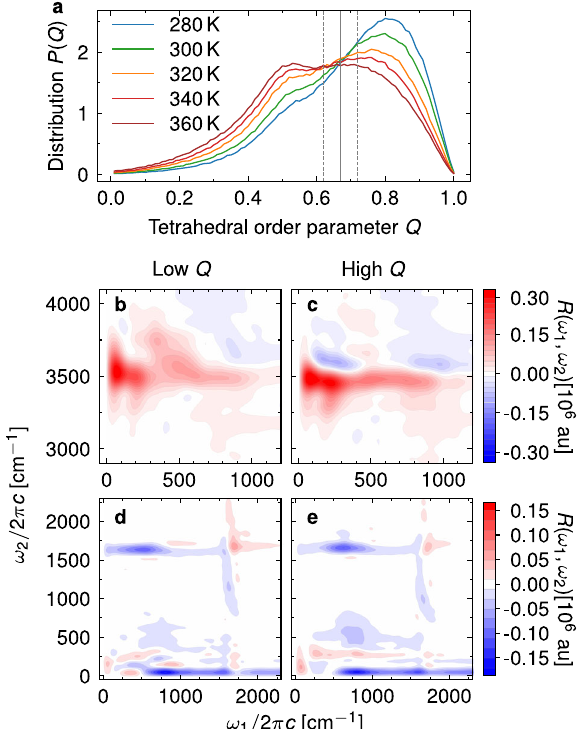
Fig. 6 | Effect of tetrahedral order on the IIR spectra. a Distribution of the local tetrahedral order parameter of liquid water as a function of temperature. The isosbestic value is indicated by the solid, grey line. Two dashed, grey lines specify the region excluded from subsequent two-dimensional IIR spectra simulations (0.62< Q <0.72). Two-dimensional IIR spectra of water molecules with high ( Q >0.72, c , e ) or low ( Q <0.62, b , d ) tetrahedral order parameter, simulated with the classical equilibrium-nonequilibrium MD approach at